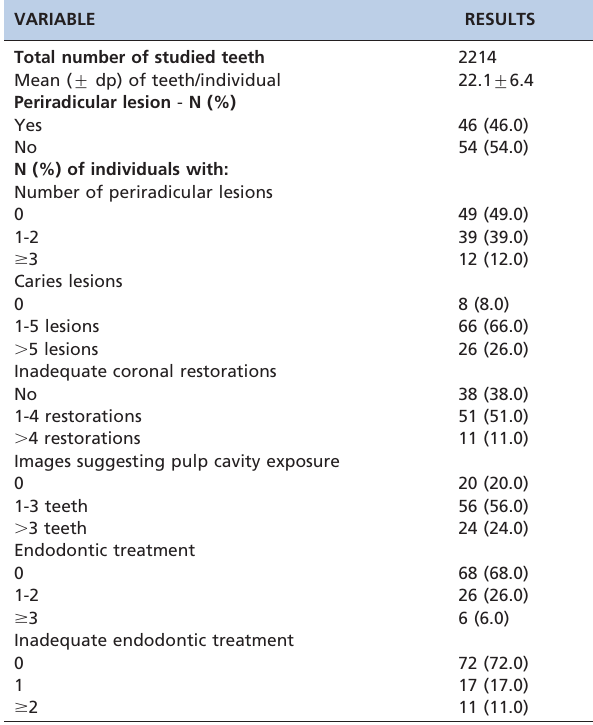
Table 3 - Radiographic characteristics of the study